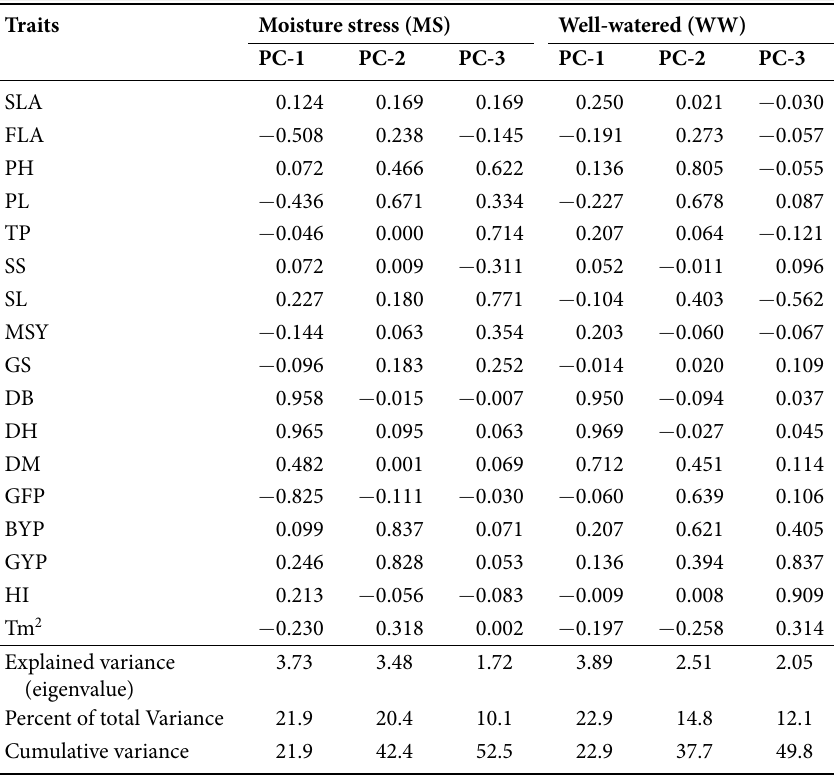
Table 6 Rotated component matrix of 17 agronomic traits of the wheat genotypes characterized in moisture stress (MS) and well-watered (WW)